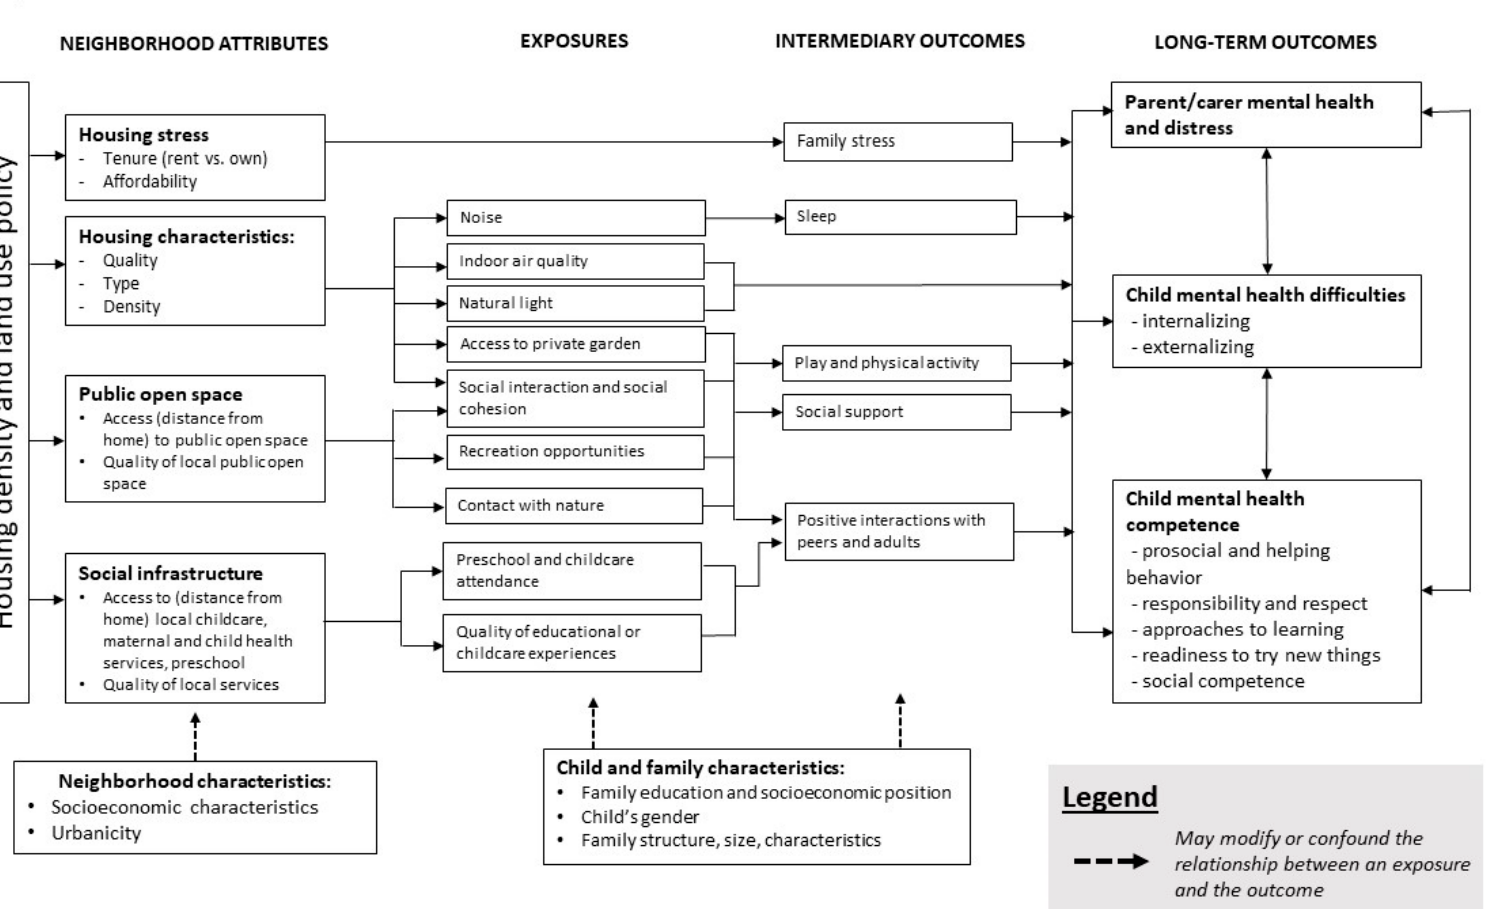
Figure 1. Conceptual framework theorizing possible pathways from the neighborhood built environment to child mental health outcomes.